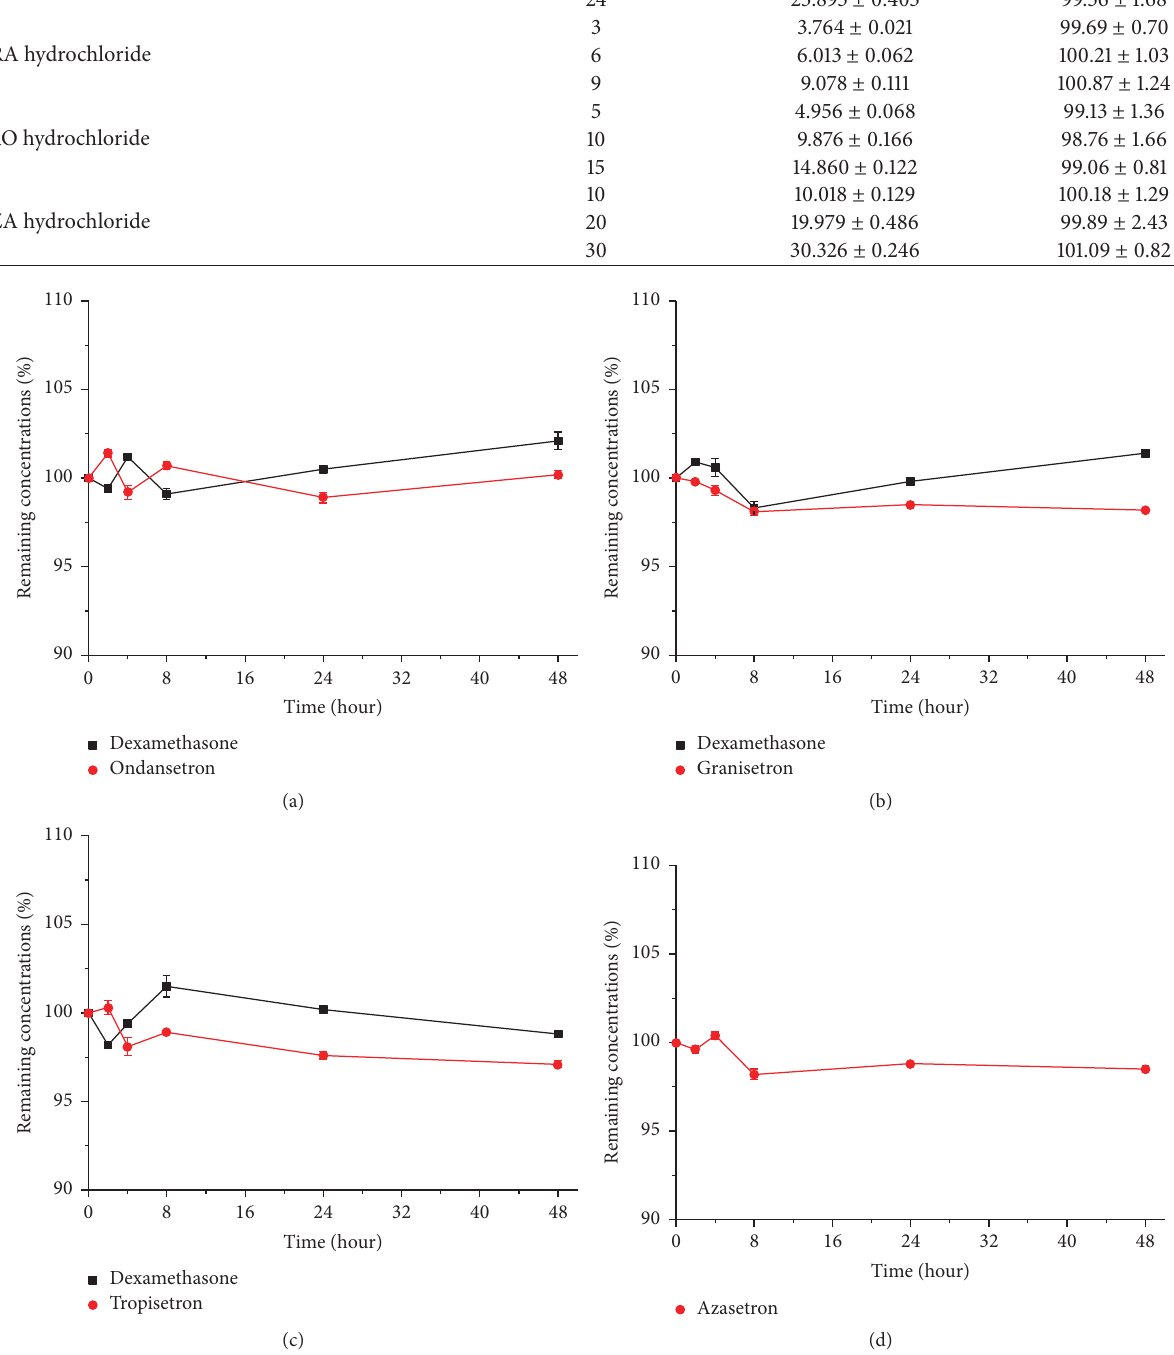
Figure 3: Drug concentrations (mean ± SD [%]; 𝑛 = 3 ) of DEX-OND, DEX-GRA, DEX-TRO, and AZA in 0.9% sodium chloride injection over 48 hours at 25 ∘